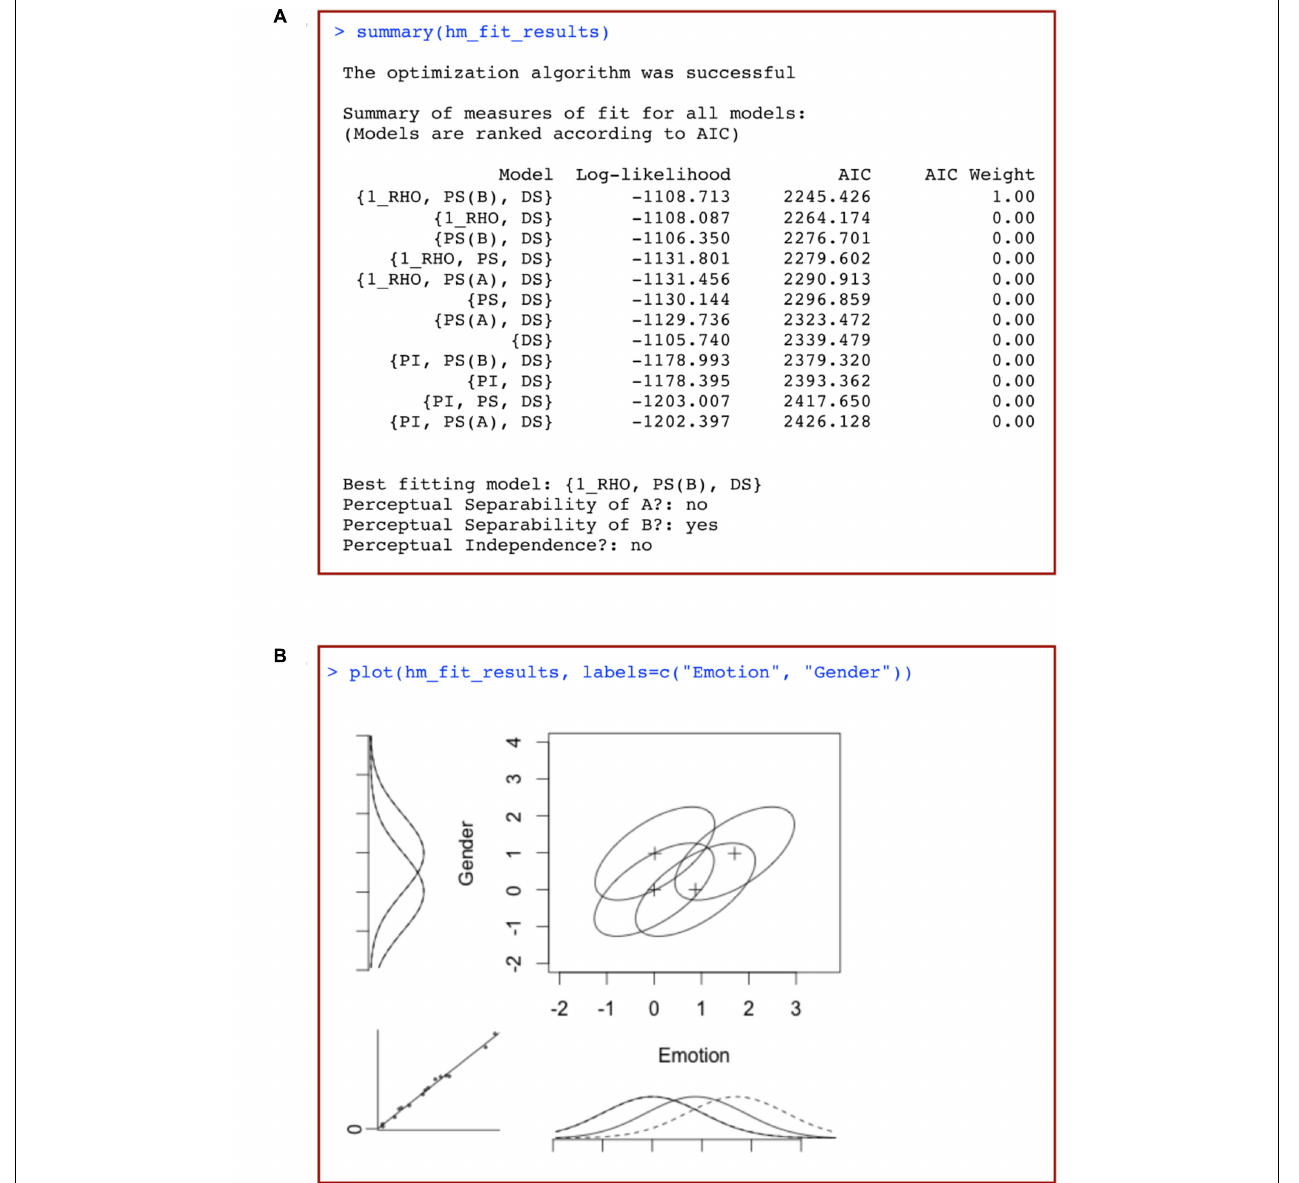
FIGURE 7 | (A) Summary of the results of a model-based analysis of data from a 2 × 2 identification task using traditional general recognition theory with grtools , and (B) plot of the best-fitting model resulting from such analysis, where marginal distributions for a given dimension are plotted using either solid or dotted lines depending on the level of the opposite dimension, and the bottom-left insert is a plot of the observed response proportions against those predicted by the